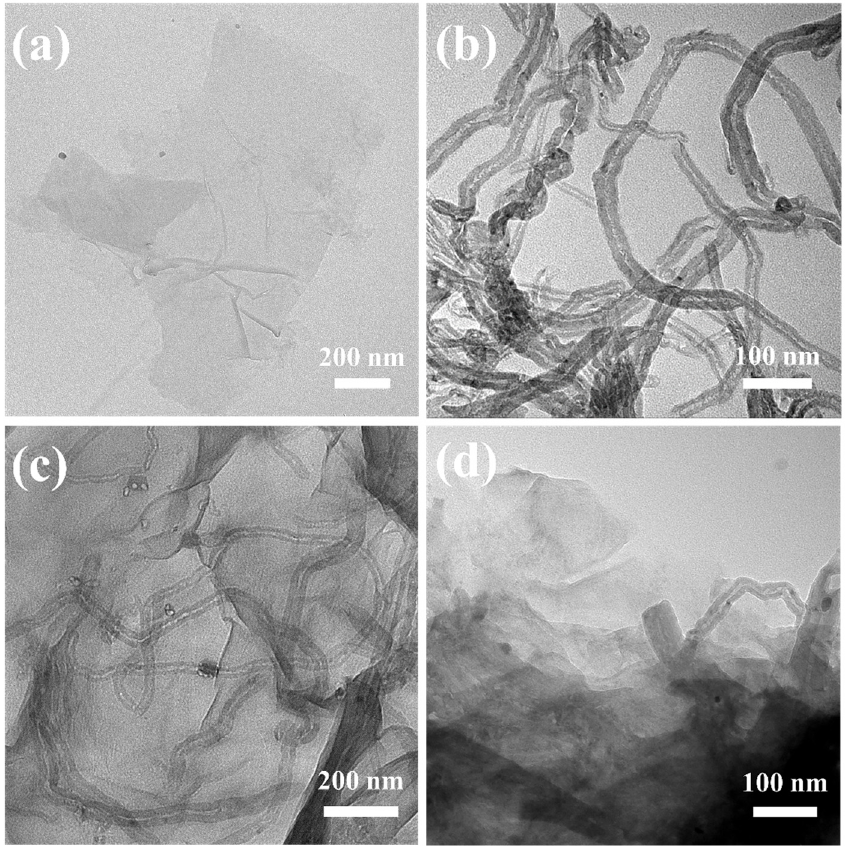
Figure 3. The TEM images of ( a ) the pristine GO, ( b ) the FCNTs, ( c ) the GO/FCNTs dispersion, and ( d ) GCEA ‐ 2 (Color figure can be viewed online).